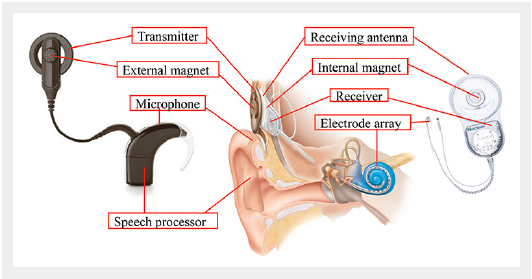
Illustration of cochlear implant components. The external parts are shown on the left, the internal components of the implant on the right. The scheme in the middle shows the position of the cochlear implant components in situ